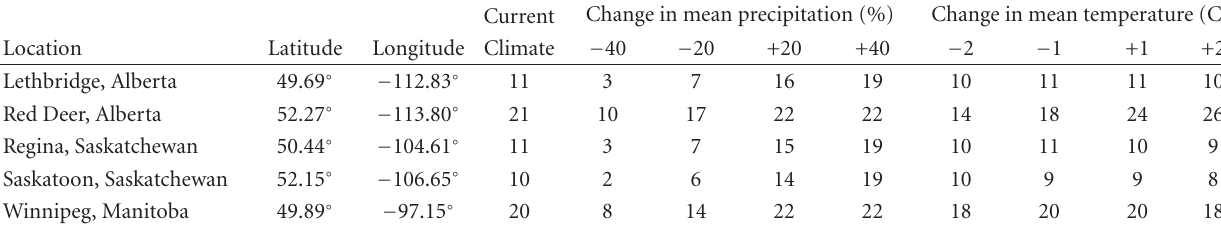
Table 2: E ff ect of changes in mean annual precipitation ( − 40% to +40%) and temperature ( − 2 to +2) from current values on Ecoclimatic Indices for Sitona lineatus at five